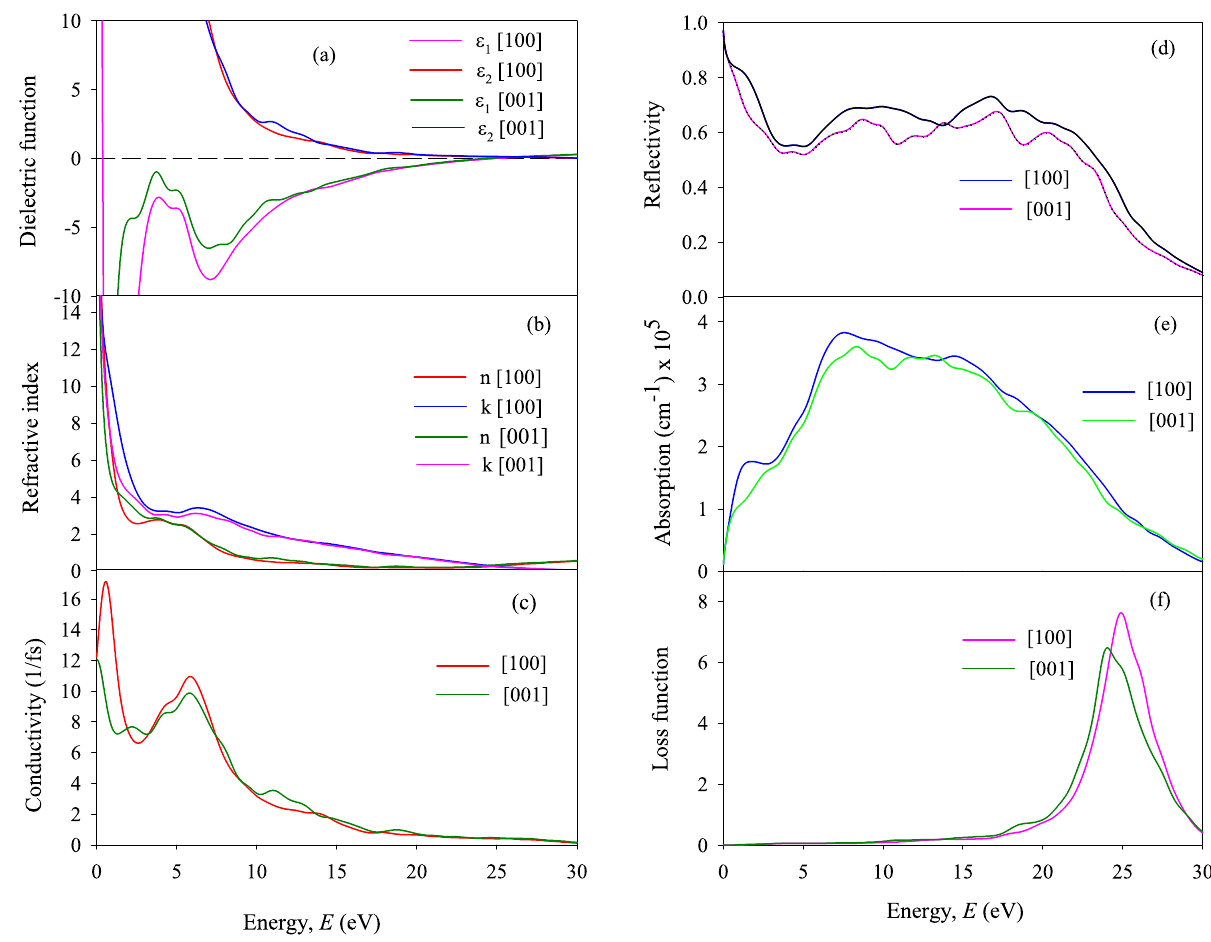
Figure 6. ( a ) Ɛ 1 ( ω ) and Ɛ 2 ( ω ), ( b ) n ( ω ) and k ( ω ), ( c ) σ ( ω ), ( d ) R ( ω ), ( e ) α ( ω ) and ( f ) L ( ω ) of TaAs for [99] and [001] electric field